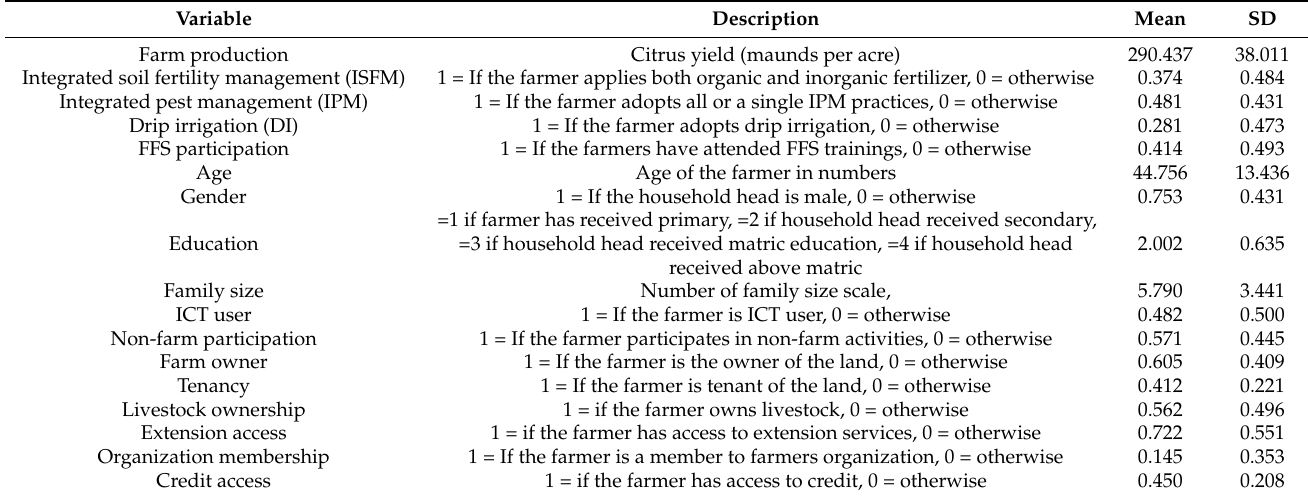
Table 1. Descriptive statistics and definition of the